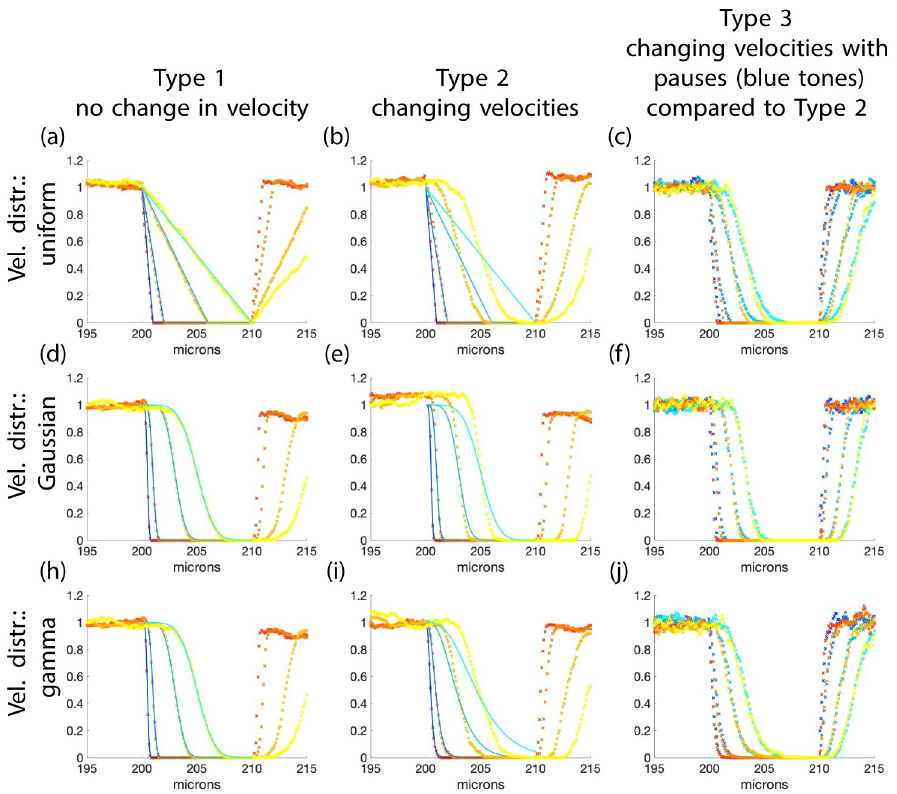
Fig 6. Impact of velocity changes and pauses on intensity profile curves. This figure shows how simulations differ between type 1, 2, and 3. The solid curves are plots of scaled versions of Eq (5) such that k f k 1 = 1 and the x’s are simulated results. The curves and x’s represent times 0.5 (blue and red), 1 (light blue and orange), 3 (lighter blue and light orange), and 5 minutes (cyan and yellow). Panels (a), (d), and (h) show type 1 simulations with x’s and theoretical curves from Eq (5) (panels are the same as (d), (g), and (j) of Fig 4). Panels (b), (e), and (i) show type 2 simulations with x’s where the filaments change velocity after a random time chosen from a uniform distribution with mean 1 minute (the theoretical curves are for comparison with column 1). In (c), (f), and (j) the blue x’s show results from type 3 simulations where the stop time comes from a uniform distribution with mean 0.5 (on average 2 ¼ 2 ) and the yellow x’s show results from type 2 for comparison (with the mean velocity 2 are moving, t on t on þ t off 3 comparable type 3 simulation). In (a)-(c) the velocity is uniformly distributed, in (d)-(f) it has a Gaussian distribution, and in (h)-(j) it has a gamma distribution. All simulations have filaments with length 10 microns. The other parameters are the same as in Fig 4. The y axis is fluorescence intensity (a.u.) in all panels. Length :